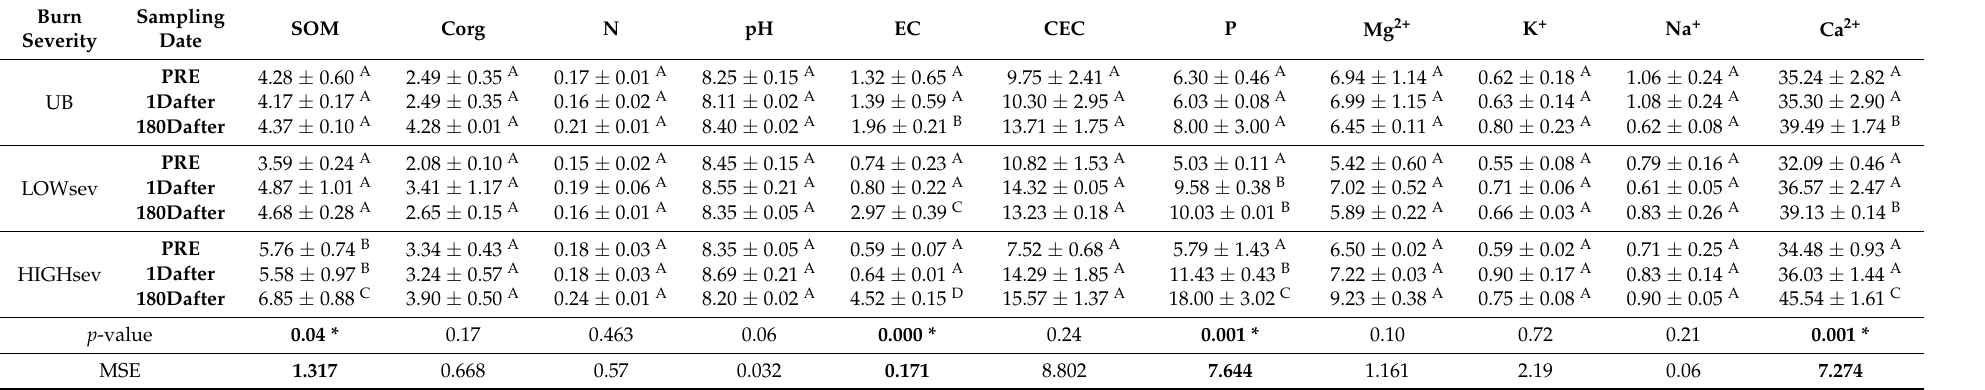
Table 1. The main soil physico-chemical properties of the burned plots before (PRE), immediately after burning (1Dafter), and 6 months after (180Dafter) (mean ± standard error) in the MedForECOtron plots: unburned (UNB), low burn severity (LOWsev), and low burn severity (HIGHsev). Capital letters indicate significant differences between the means of the different groups (Fisher’s least significant difference test); MSE: mean squared